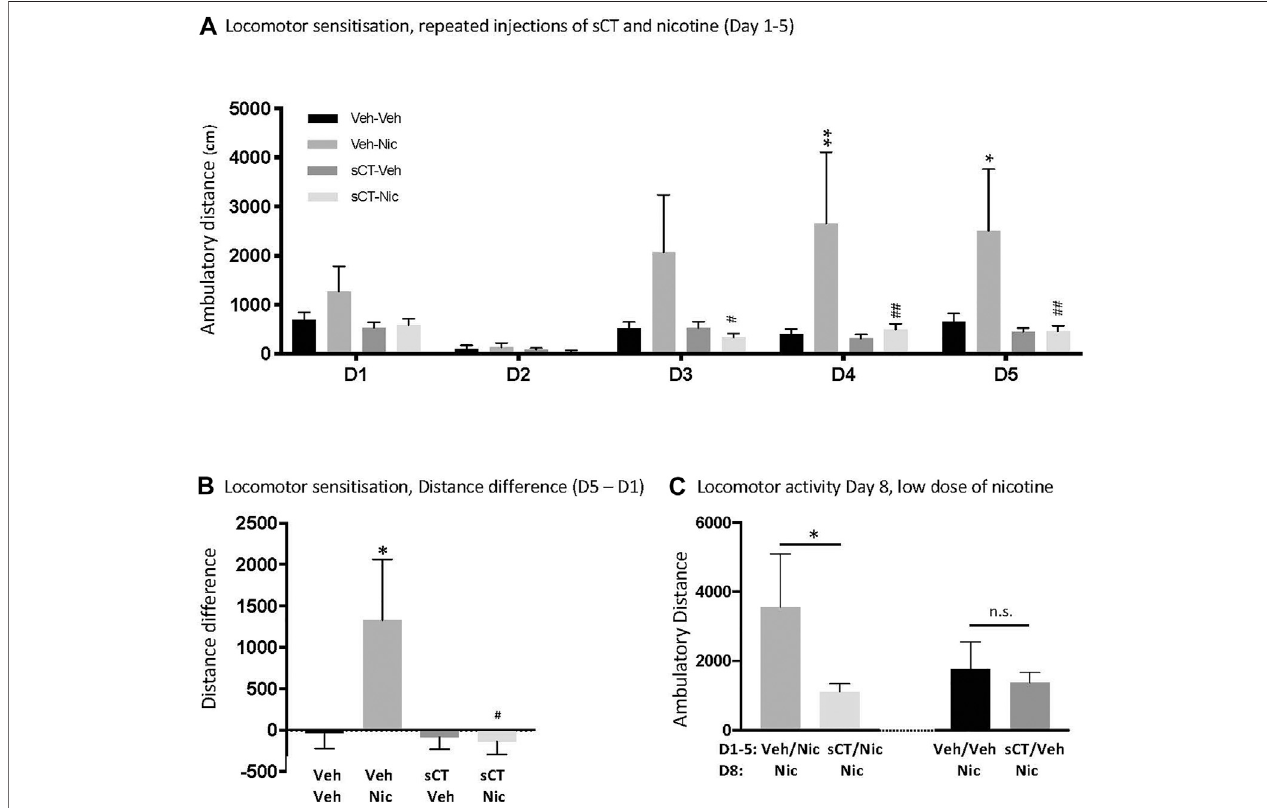
FIGURE2| EffectsofrepeatedadministrationofsCTandnicotineonlocomotorsensitisationinmalemice (A) Repeatednicotine(Nic)administration(0.5 mg/kg,IP) for 5 days (D1-D5) increased locomotion in mice, when compared to vehicle (Veh) at days 4 and 5 of administration (* p < 0.05, ** p < 0.01, for the Veh-Nic vs . Veh-Veh comparisons). Locomotor stimulation was lower at Day 3 – 5 in mice pre-treated with sCT (5 μ g/kg, IP) prior to nicotine, compared to those pre-treated with vehicle ( # p < 0.05, ## p < 0.01, for the Veh-Nic vs . sCT-Nic comparisons). There was no difference in nicotine locomotor response between the sCT-nicotine or vehicle-vehicletreatedmice.sCThadnoeffect perse onlocomotoractivityatanyday,whencomparedtothevehiclegroup (B) Thedifferenceoftravelleddistance between D5-D1 was higher in vehicle-nicotine treated mice compared to vehicle-vehicle treated mice (* p < 0.05, for the Veh-Nic vs . Veh-Veh comparisons). The D5-D1 difference of travelled distance was lower in the sCT-nicotine compared to vehicle-nicotine treated mice ( # p < 0.05). There was no difference in locomotor response between vehicle-vehicle and sCT-nicotine treated mice (C) On Day 8 (D8), mice previously treated with vehicle-nicotine (Veh/Nic) during Day 1 – 5 (D1-5) showed higher locomotion response to a low dose of nicotine (Nic, 0.25 mg/kg, IP), compared to mice treated with sCT-nicotine (sCT/Nic) during D1-D5 (* p < 0.05). There was no difference in the locomotor activity response to a low dose of nicotine (Nic) between groups previously treated with vehicle-vehicle (Veh/ Veh) or sCT-vehicle (sCT/Veh) during D1-D5. Data are presented as mean ± SEM.